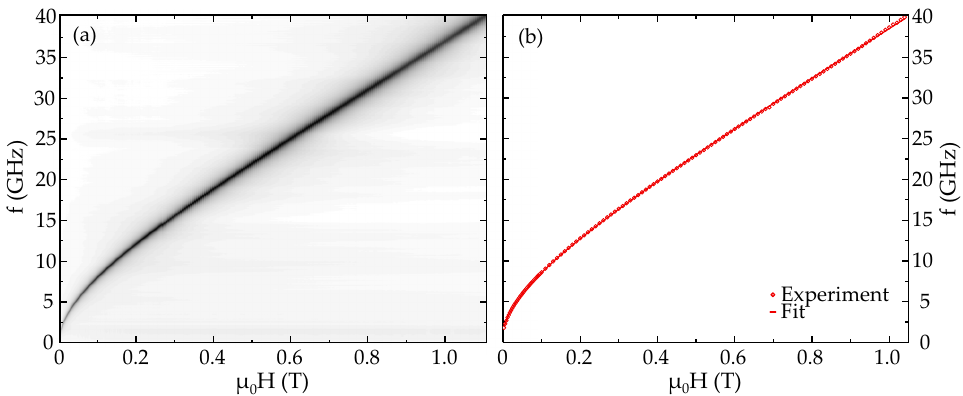
Figure 2. ( a ) In-plane VNA-FMR data for a 50 nm thick Py film [15] showing the frequency–field characteristics. The color variation shows the absorption intensity. ( b ) Extracted experimental data (points) from ( a ) and corresponding fit